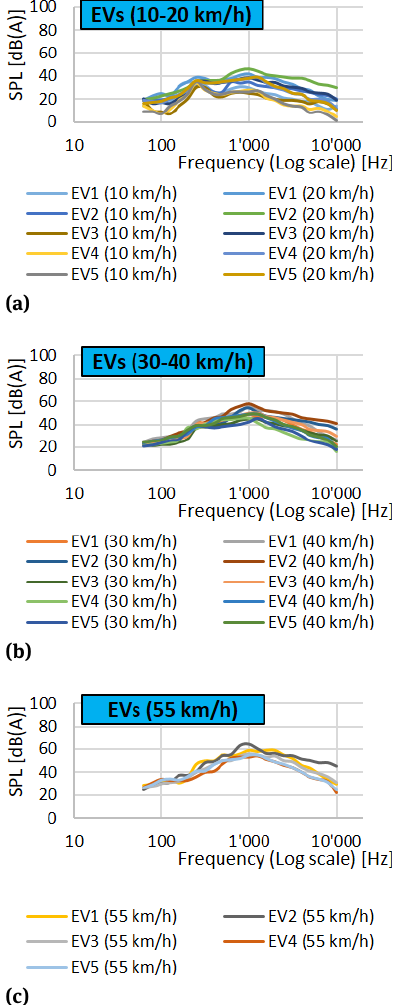
Figure 5: A-weighted Sound Pressure Level (ISO 362-1-1:2015) of five different EVs at constant speeds